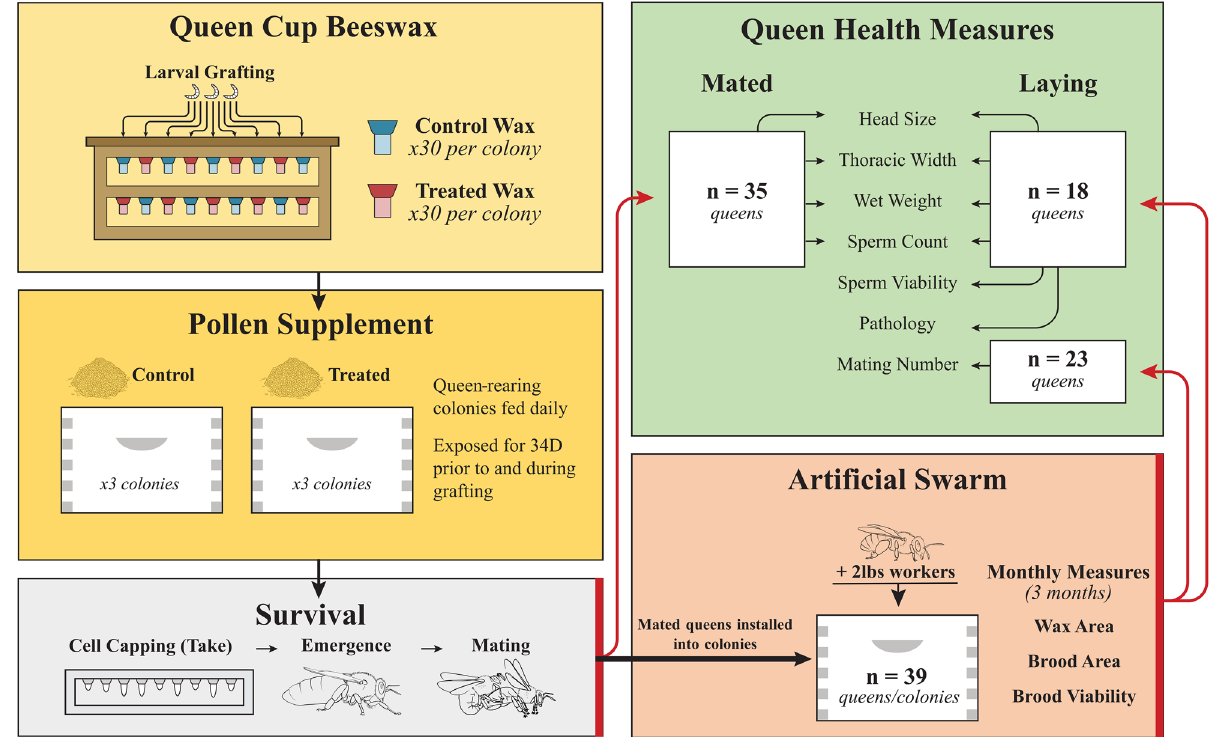
Figure 1. Graphical process diagram depicting experimental methods and sample sizes at different assessment